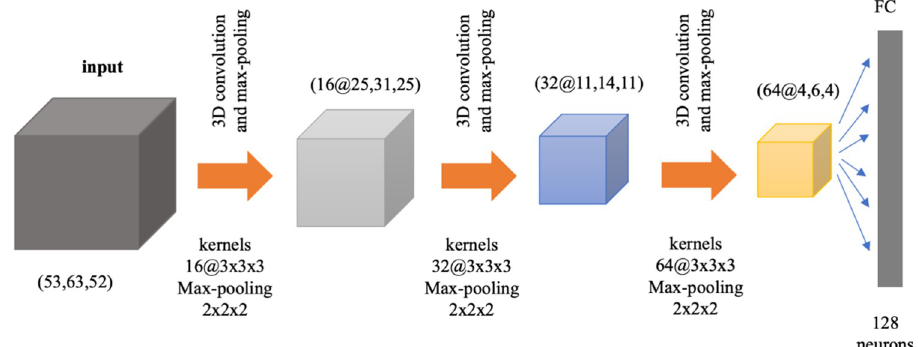
Fig 2. CNNs architecture. The CNNs block consists of three 3D convolutional layers, with kernels of sizes 3 × 3 × 3, each of which is followed by a max-pooling layer with a kernel of size 2 × 2 × 2.